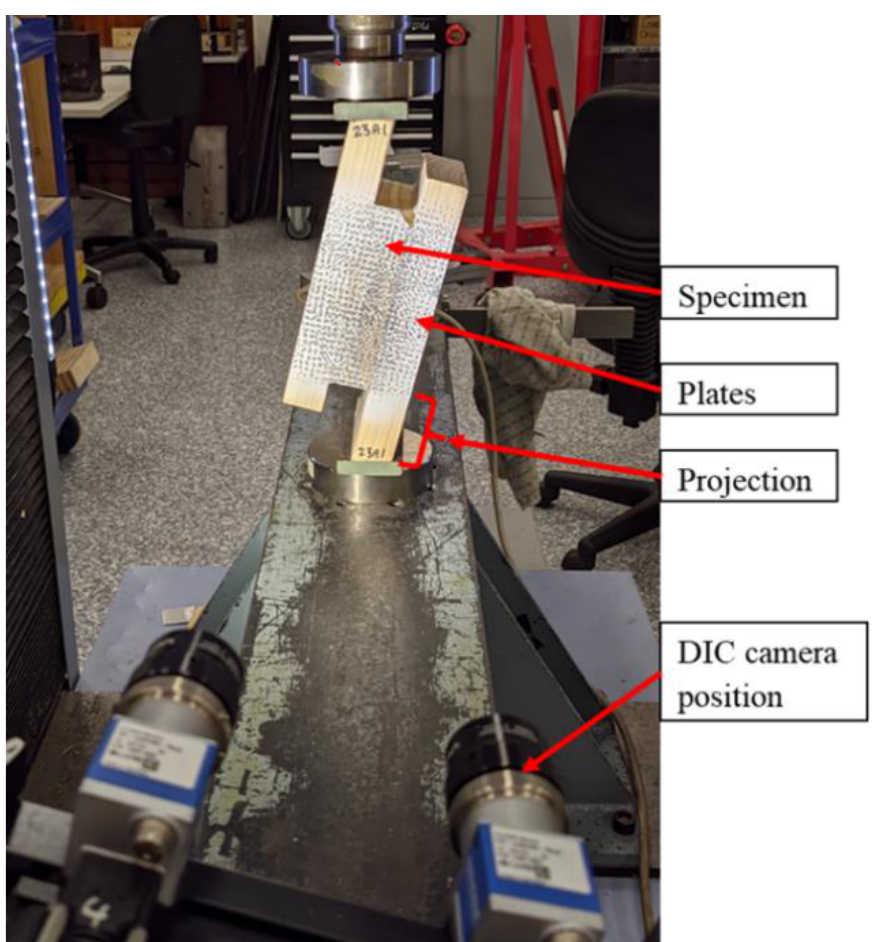
Figure 1. Experimental test setup of RS sample, and DIC positioning.